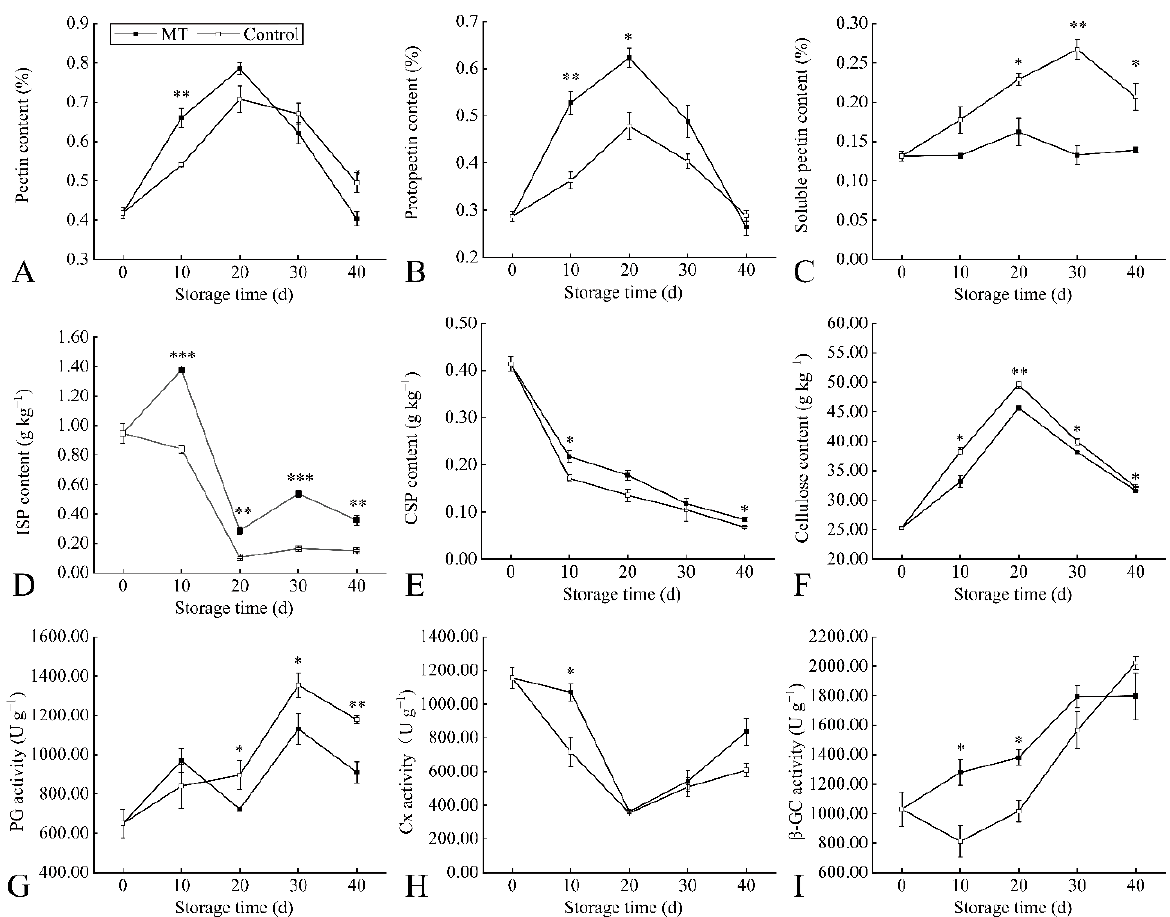
Figure 6. Melatonin treatment affects physiological indexes of fruit during storage. Changes in pectin content ( A ), protopectin content ( B ), soluble pectin content ( C ), ISP content ( D ), CSP content ( E ), cellulose content ( F ), PG activity ( G ), Cx activity ( H ), and β -GC activity ( I ). Values represent mean ± standard deviation based on three independent biological replicates. * represents p < 0.05 for significance between treatments, ** represents p < 0.01, *** represents p < 0.001.